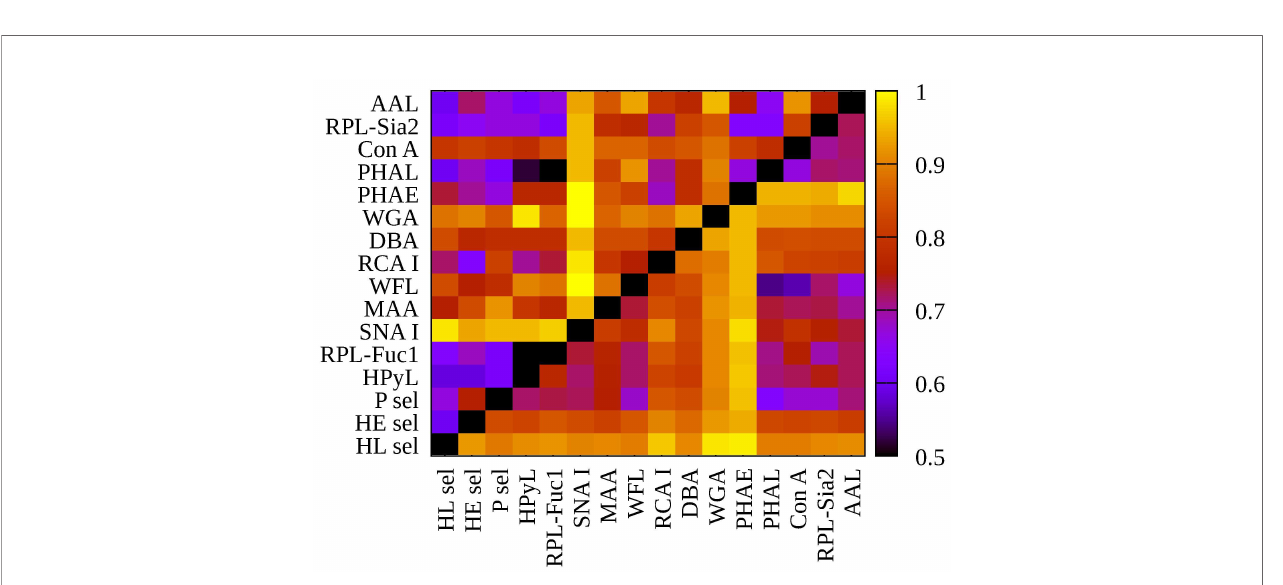
FIGURE 2 | Heat map generated using 16 lectins and their performance according to AUC value for two submatrices, i.e., hY vs. hO (left upper triangle) and hO vs. CRC (right lower